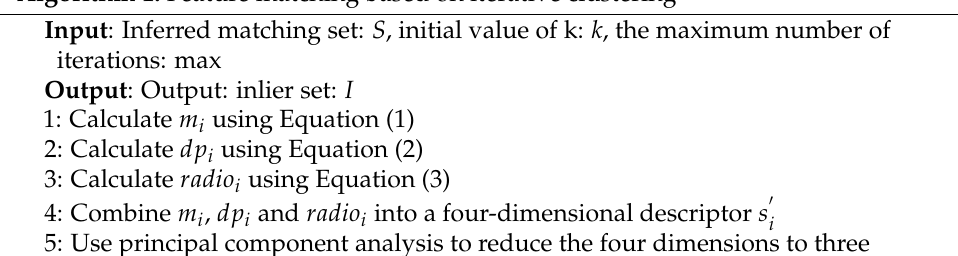
Algorithm 1: Feature matching based on iterative